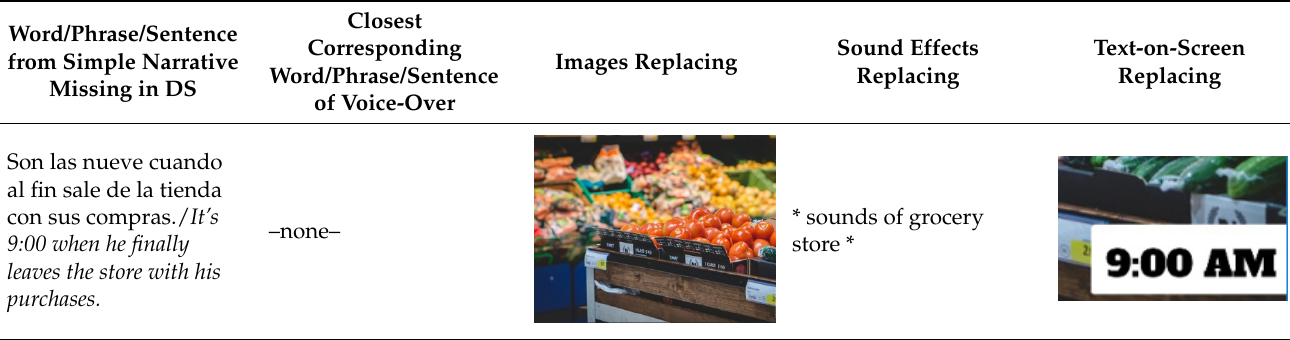
Table 10. Sofia’s transduction through digital synesthesia.